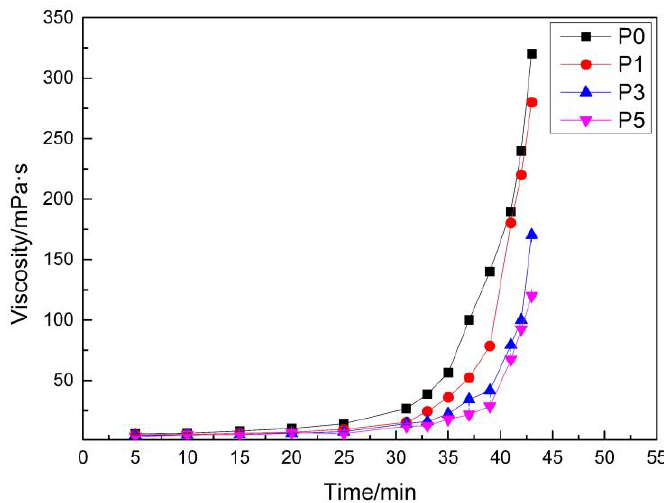
Figure 5. The relationship between viscosity and time of different ratio systems.